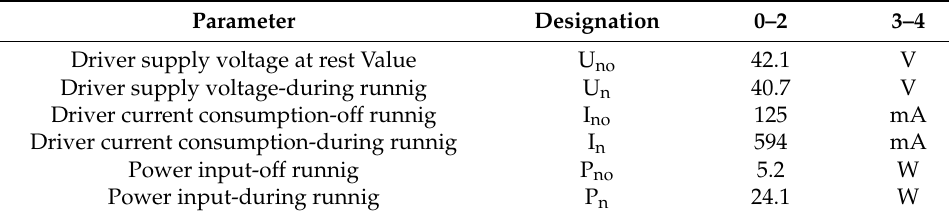
Table 3. Outputs from the measurement of the individual cutting disc drive